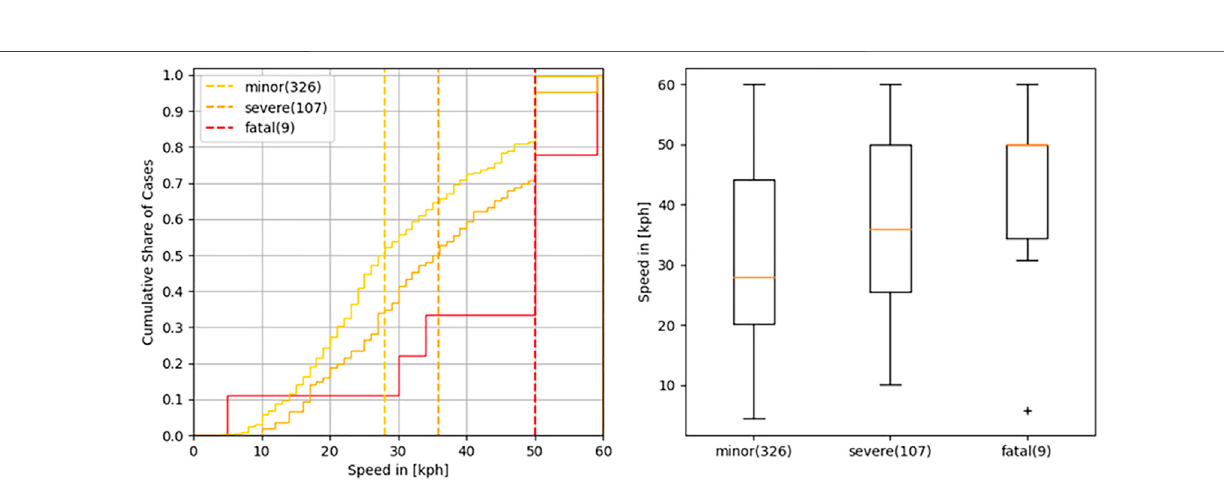
Frontiers in Future Transportation |